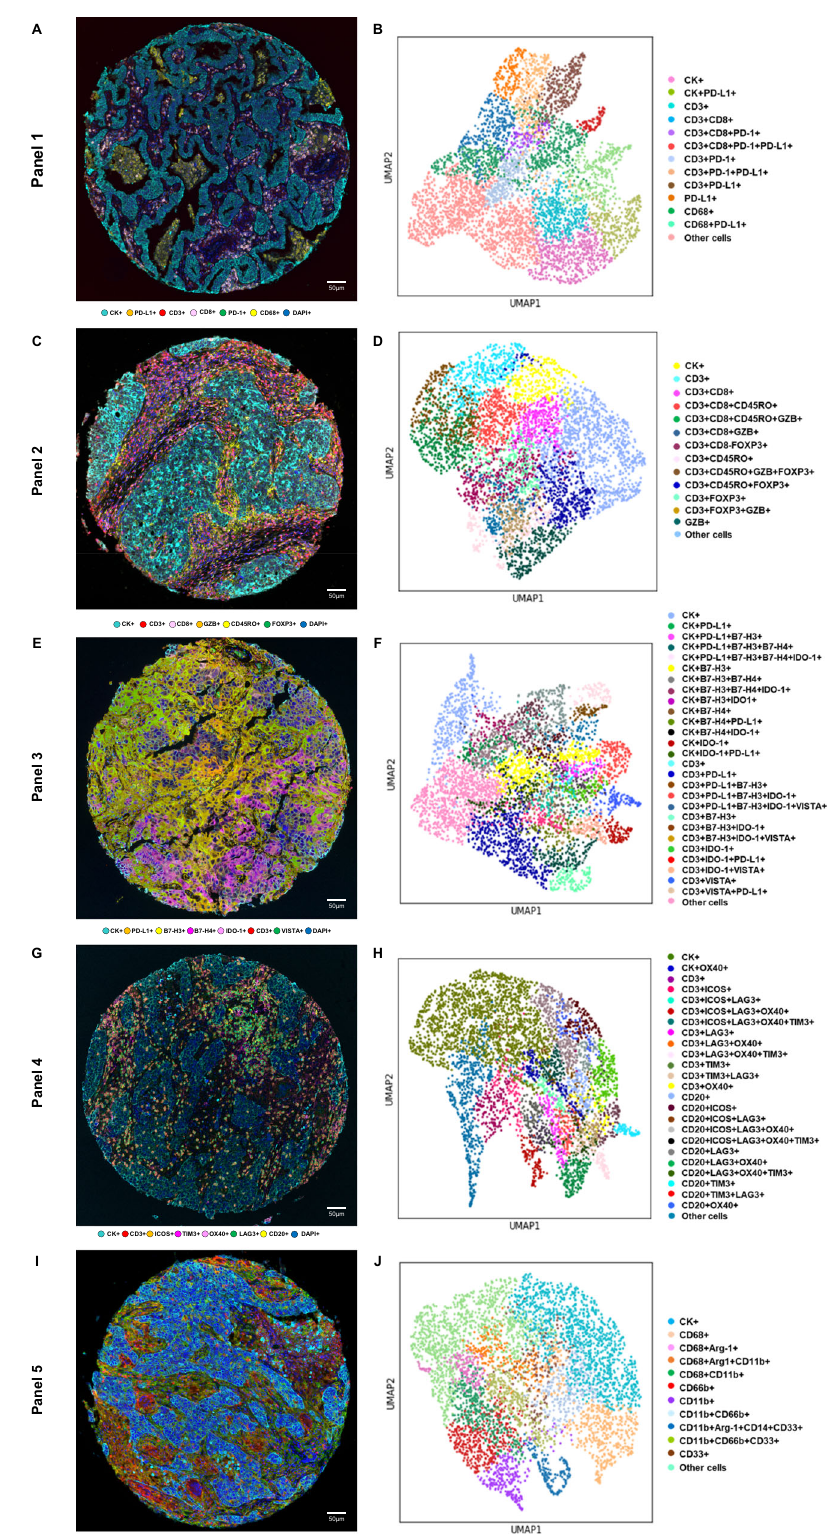
panel 2. This illustrates the heterogeneity of marker co-expression, suggesting that several pathways may be activated in the malignant cells as part of their escape from immune surveillance. Overall, the cellular densities of the most frequently observed checkpoint mole- cules were higher in malignant cells from SCC than in those from ADC. The most predominant immune checkpoint expressed in